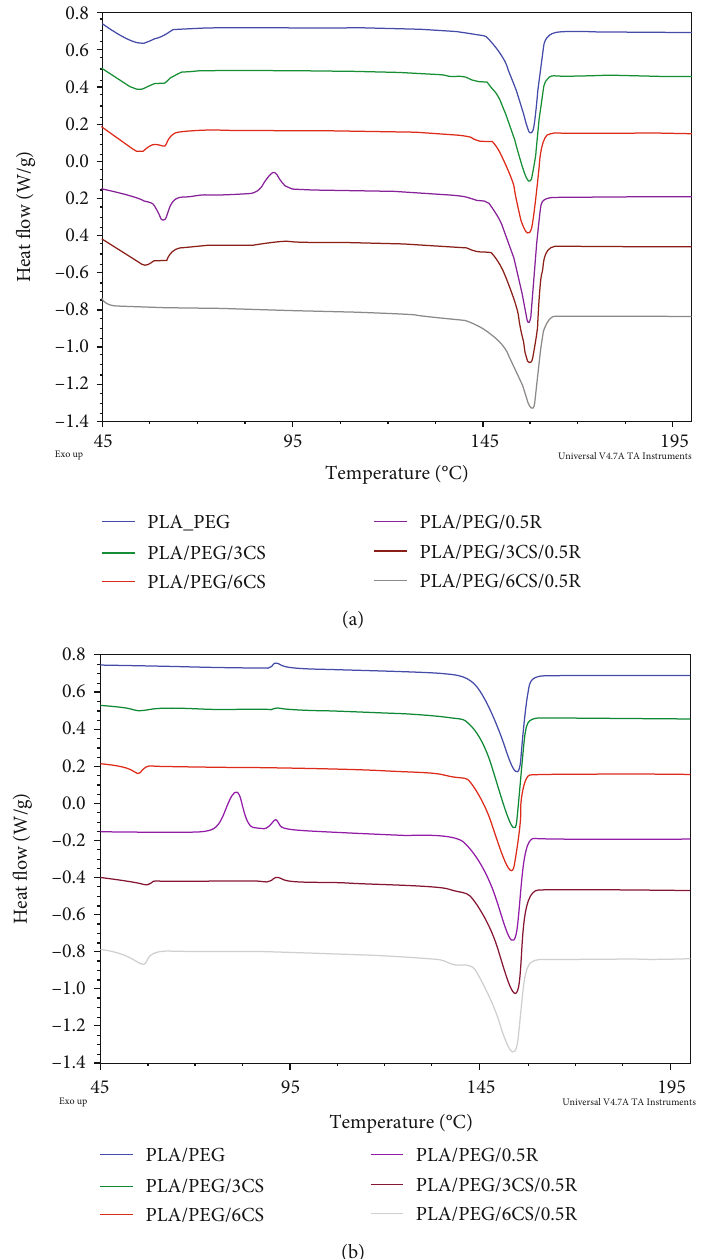
Figure 1: DSC curves of plasticized PLA, PLA/PEG/R, and PLA/PEG/CS/R biocomposites, recorded in the fi rst heating run (a) and the second heating run